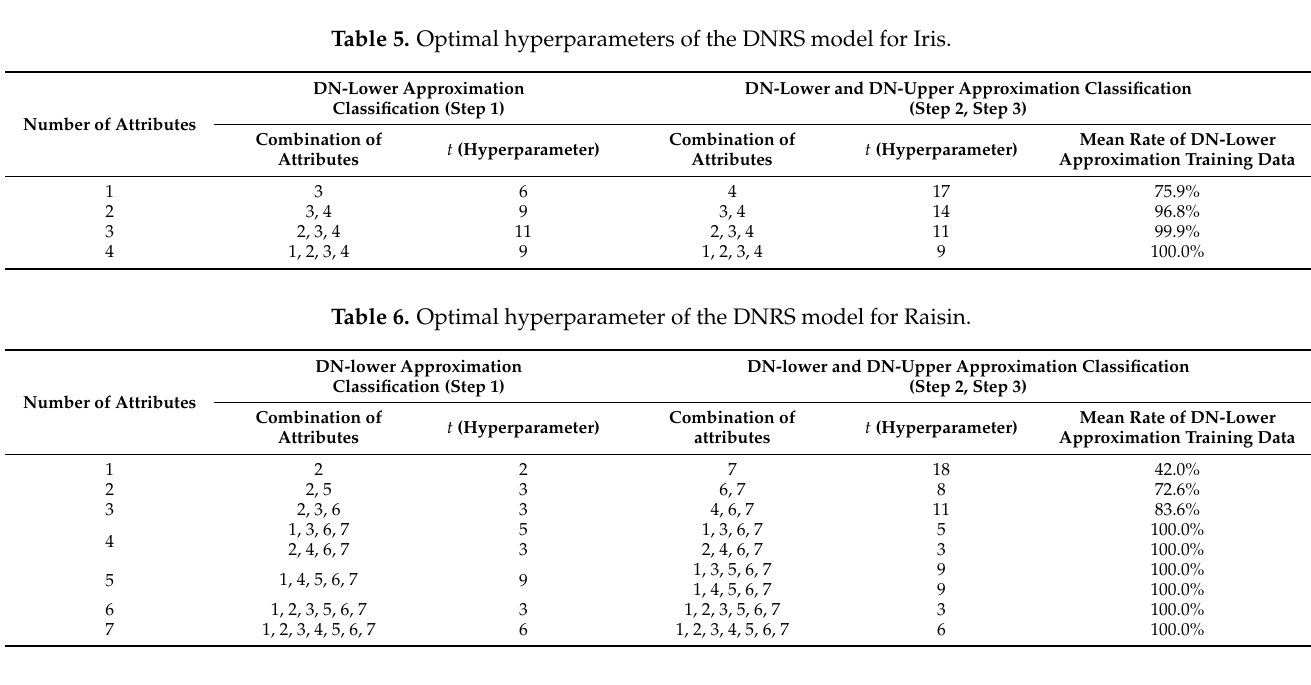
Table 7. Optimal hyperparameters of the DNRS model for Rice.